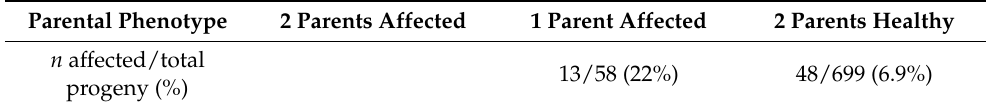
Table 4. Prevalence of corneal sequestra in function of the parental